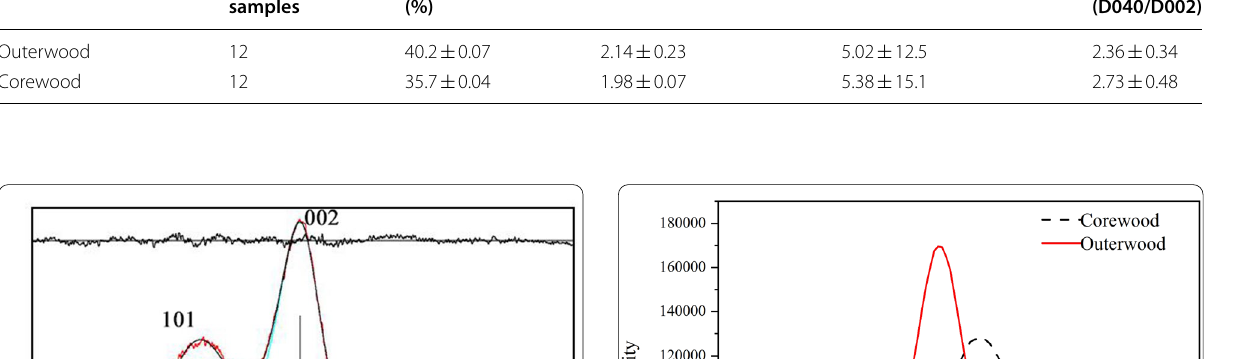
Table 2 The relative crystallinity and crystallite size of Pinus radiata outerwood and corewood Sample location